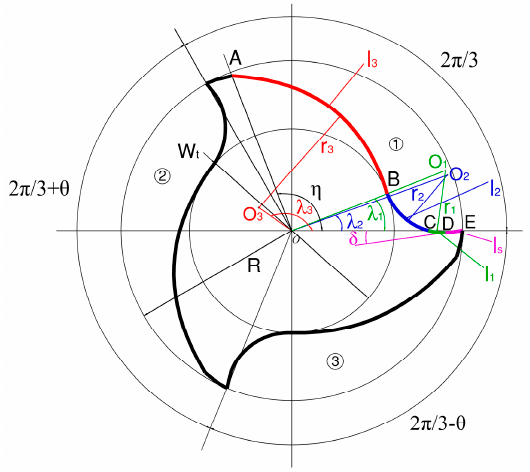
Figure 2. Radial section design parameters.